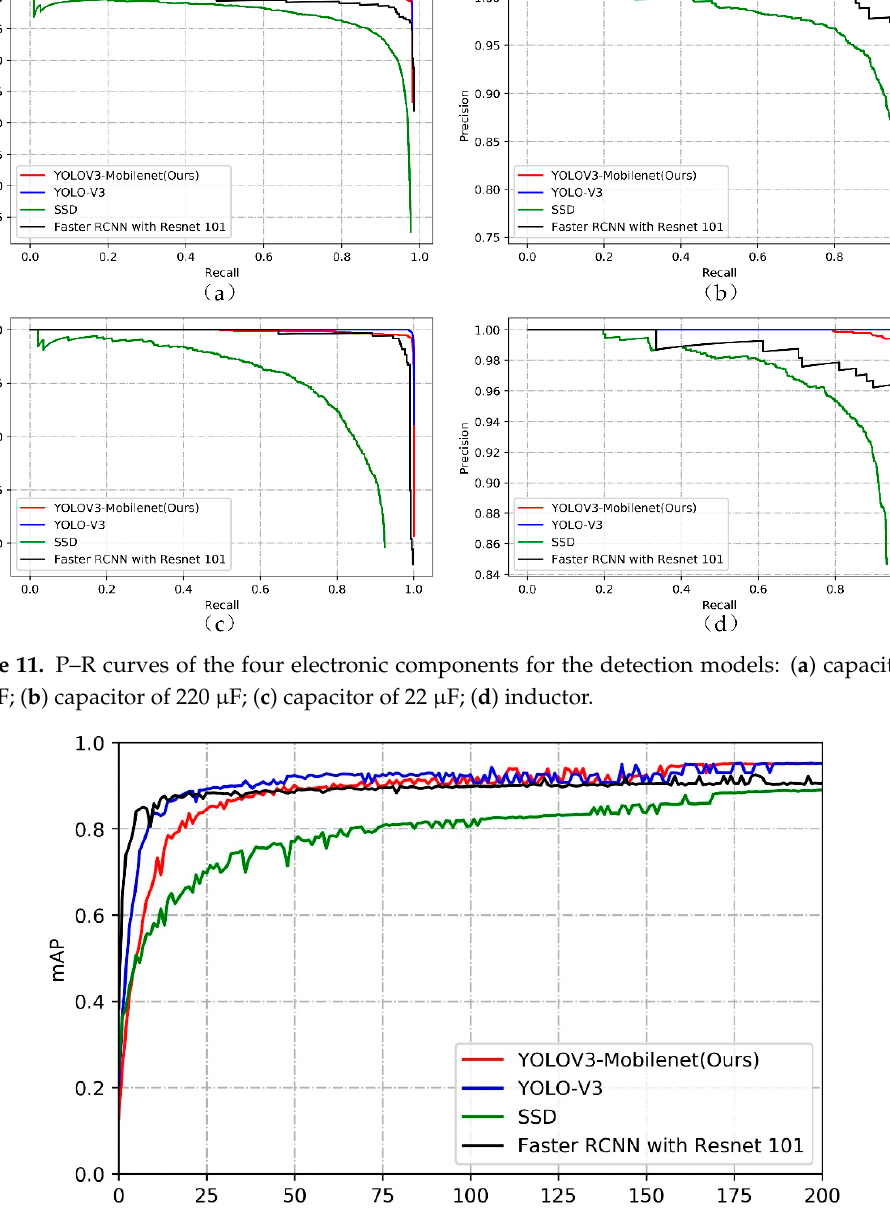
Table 6. mAP results and detection speed for several models.